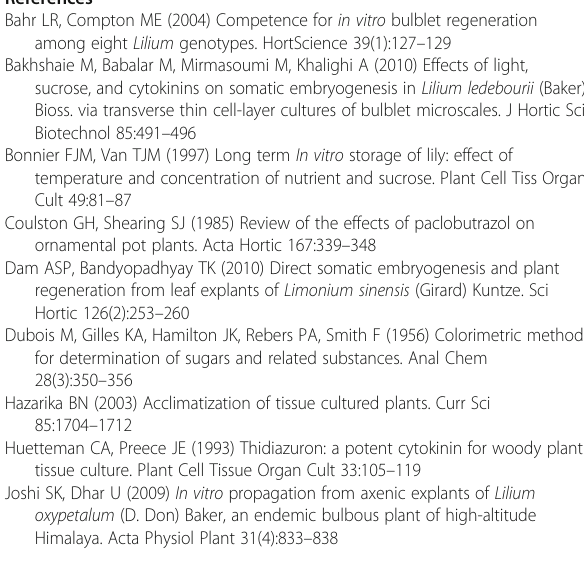
(10 mg/l) and indirect micropropagation by MS supple- mented with TDZ (0.5 mg/l) + 2,4-D (5 mg/l) or using 2ip (0.5 mg/l) + picloram (5 mg/l). Using 60 g/l of sucrose plus 3 or 6 mg/l of paclobutrazol led to the highest num- ber of bulblets/explant. The highest bulblet diameters were recorded with 120 g/l sucrose plus 6 or 3 mg/l paclobutrazol.